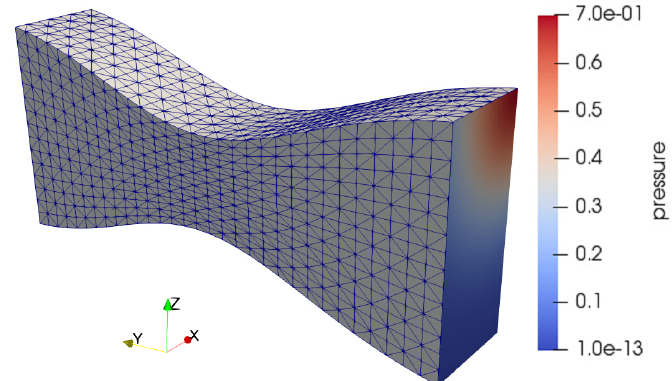
Figure 5. Academic test case: mesh and pressure field represented on its surface of application; the axis of rotation is located on the left of the object along the x-axis.